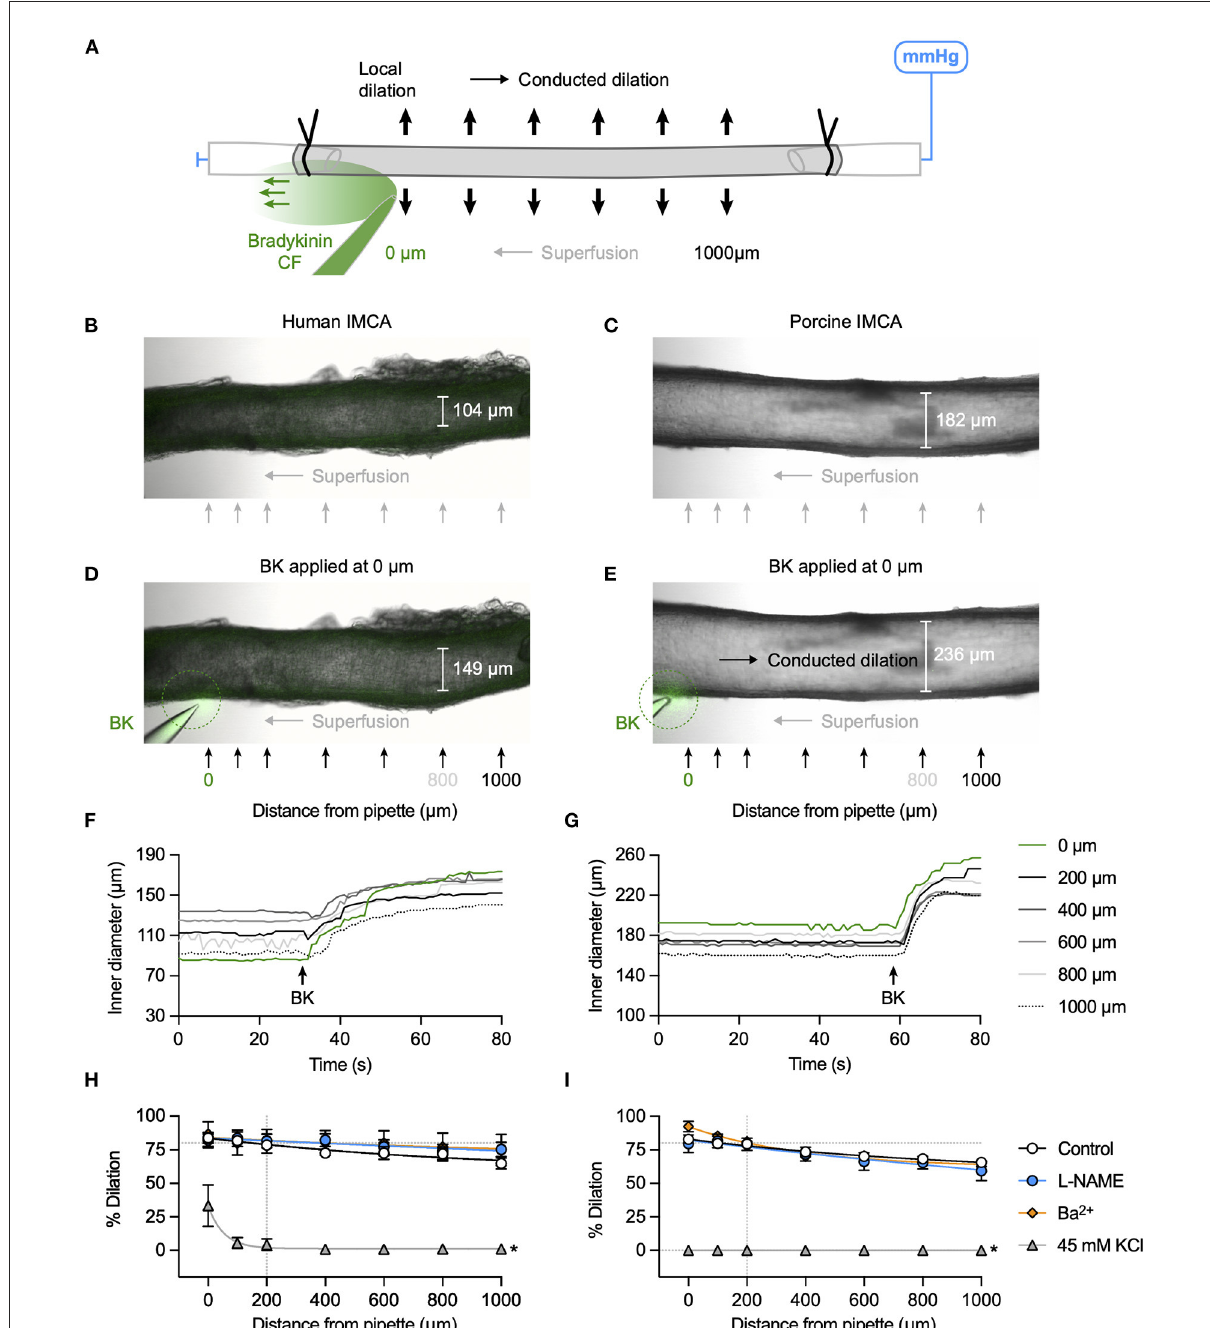
FIGURE3 K + channel-mediated vasodilation underlies conducted dilation of human and porcine RA-IMCAs. (A) Schematic of experimental setup with direction of flow of bradykinin (BK) indicated by carboxyfluorescein (CF). Micrographs showing an isolated, cannulated and pressurized human (B ) and porcine (C) artery. Focal application of BK (and CF, green) to the downstream end of the artery against the direction of superfusion flow caused local and conducted dilation in both human (D) and porcine (E) arteries. The corresponding time course of responses are shown in (F,G) , and Supplementary Videos S2, S3. A bolus of bradykinin was delivered at the point indicated by the arrow, and simultaneous inner diameter measured locally (0 µ m) and up to 1,000 µ m upstream, positions indicated by arrows in (D,E) . The same human artery used for K Ca 3.1 immunolabel in Figure 6A. Summary graphs show that compared to control ( n = 9, 14) neither L-NAME (100 µ M, n = 3, 6) nor Ba 2 + (30 µ M, n = 3, 3) affected local or conducted dilation, whereas depolarization to 45mM KCl abolished conducted dilation ( n = 3, 6) in human (H) and porcine (I) arteries, respectively. Non-parametric mixed effects analysis with Sidak’s multiple comparison test; * P < 0.05 vs.